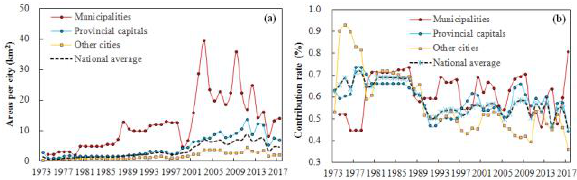
Figure 4. Cultivated land losses in different administrative-level cities (a) annual occupied area per city; (b) contribution